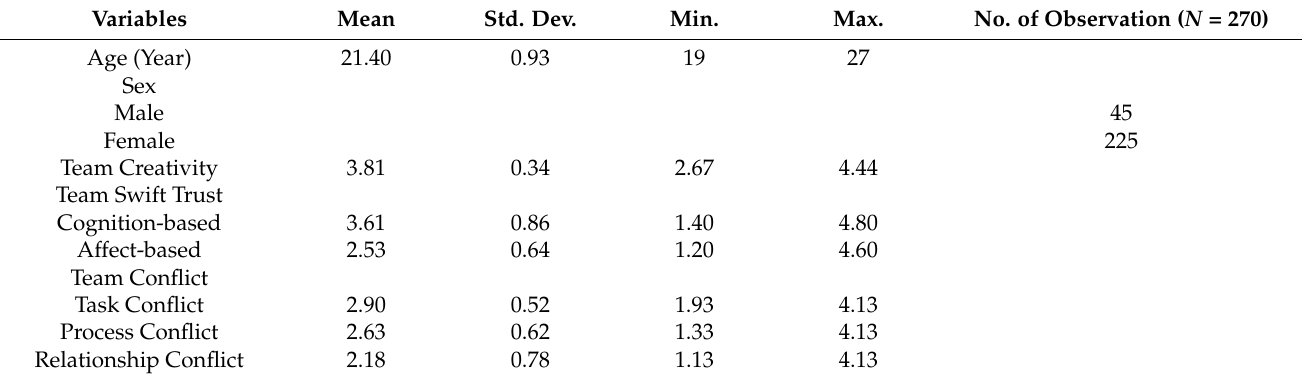
Table 1. Participants’ demographic characteristics and aggregation mean scores for teams ( N = 54).